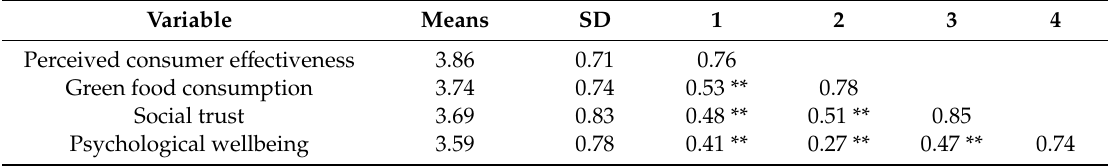
Table 3. Means, standard deviation, and Pearson correlation ( N =